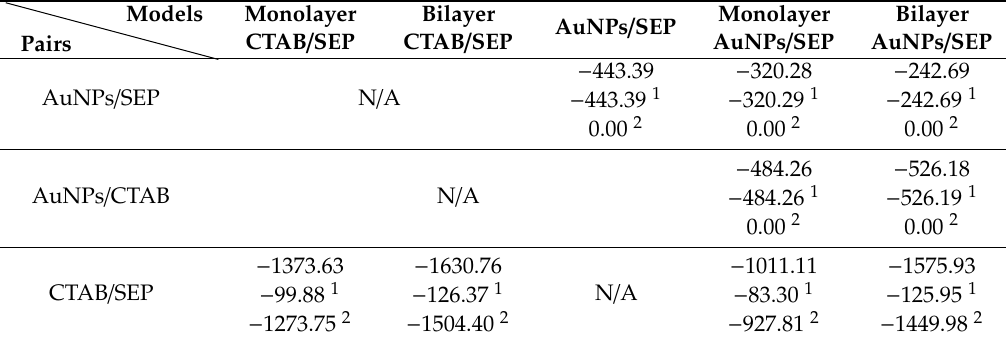
Table 2. Interaction energies and its components for each models (kcal/mol).